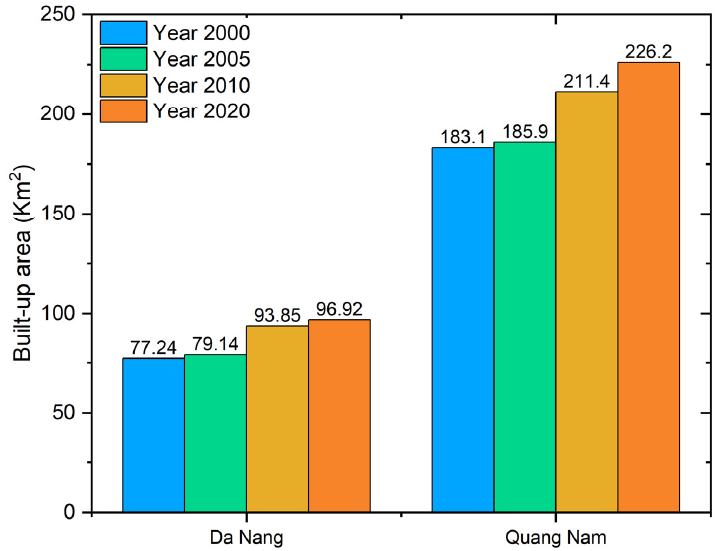
Figure 5. The summary of the built-up area of Da Nang city and Quang Nam province in 2000, 2005, 2010, and